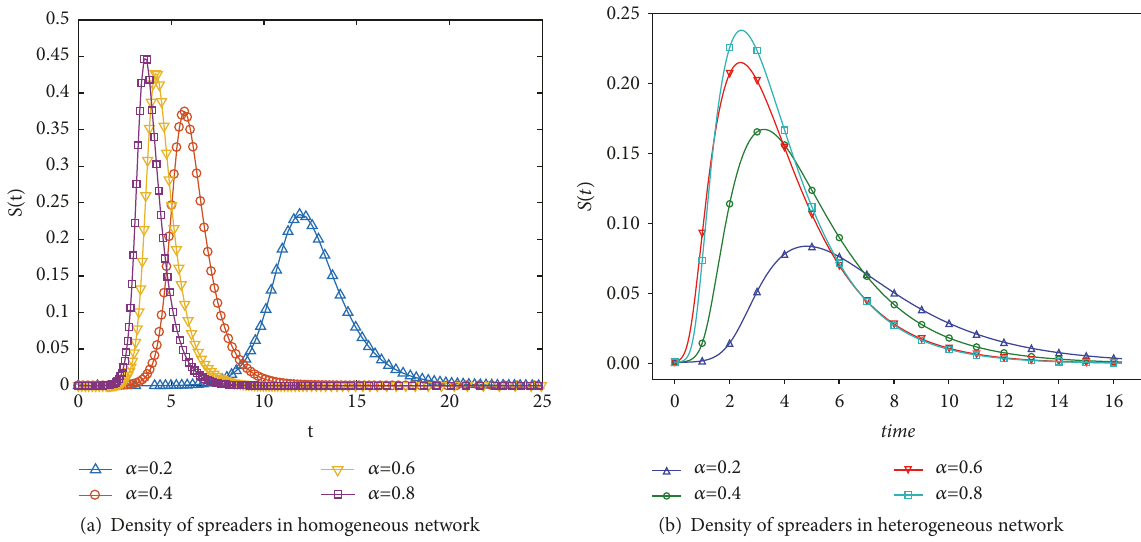
Figure 5: The evolution of spreaders varying over the activity rate 𝛼 with 𝛽 = 0.1 , 𝜆 = 0.5 , and 𝛿 = 0.6 .